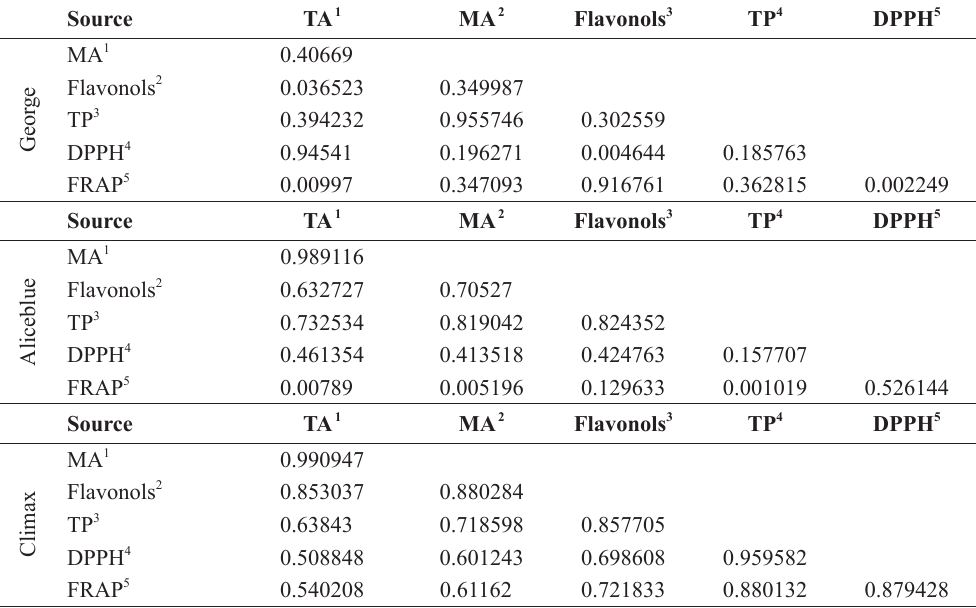
Correlation coefficients (r²) of total and monomeric anthocyanins, flavonols, total phenolic and antioxidant capacity (FRAP and